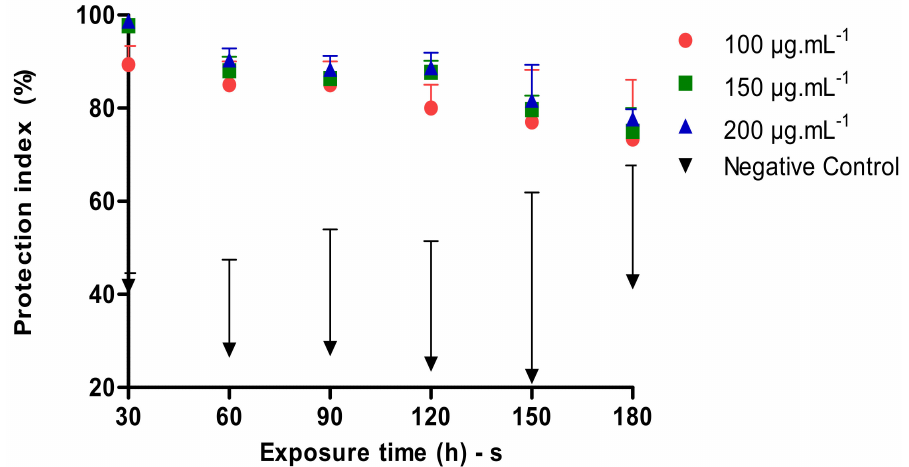
Figure 3. Repellent activity of P. heptaphyllum nanoemulsion against A. aegypti